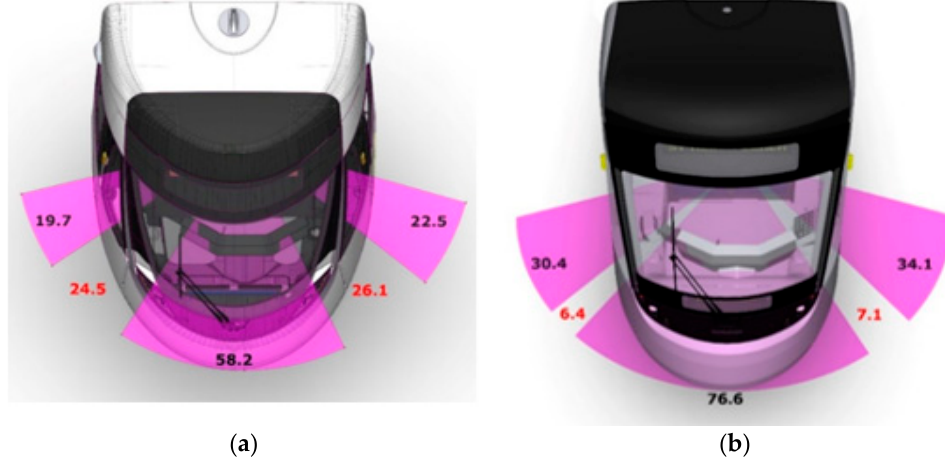
Figure 6. Change in frontal view: ( a ) initial design, and ( b ) final design.